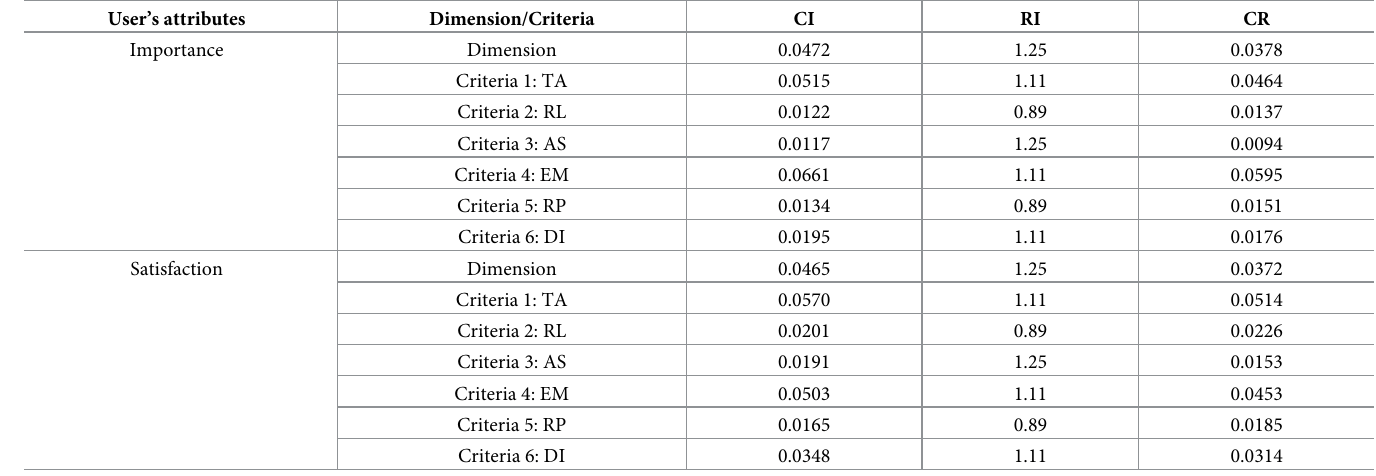
Table 6. Consistency